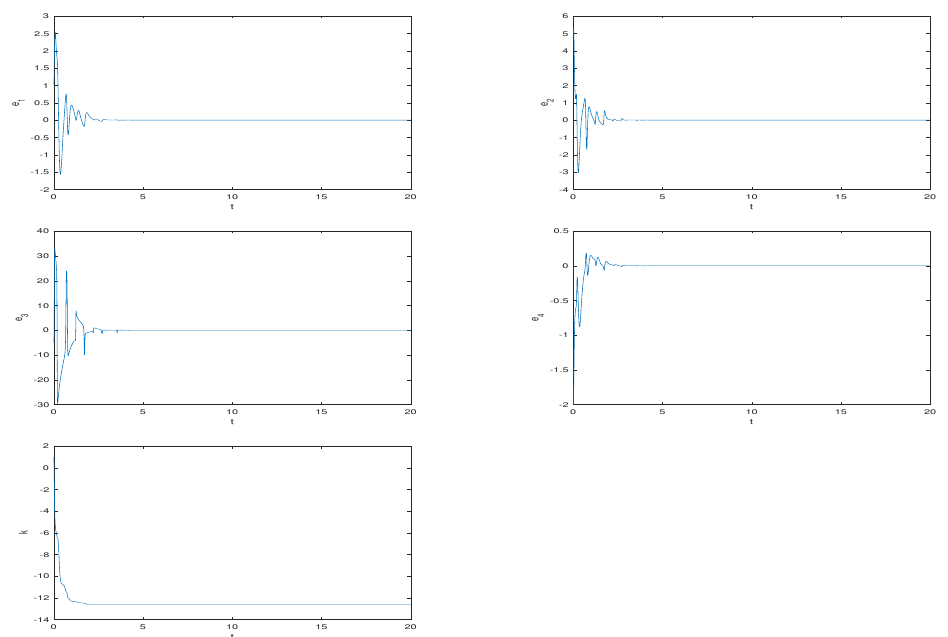
Figure 18. Adaptive synchronization for system